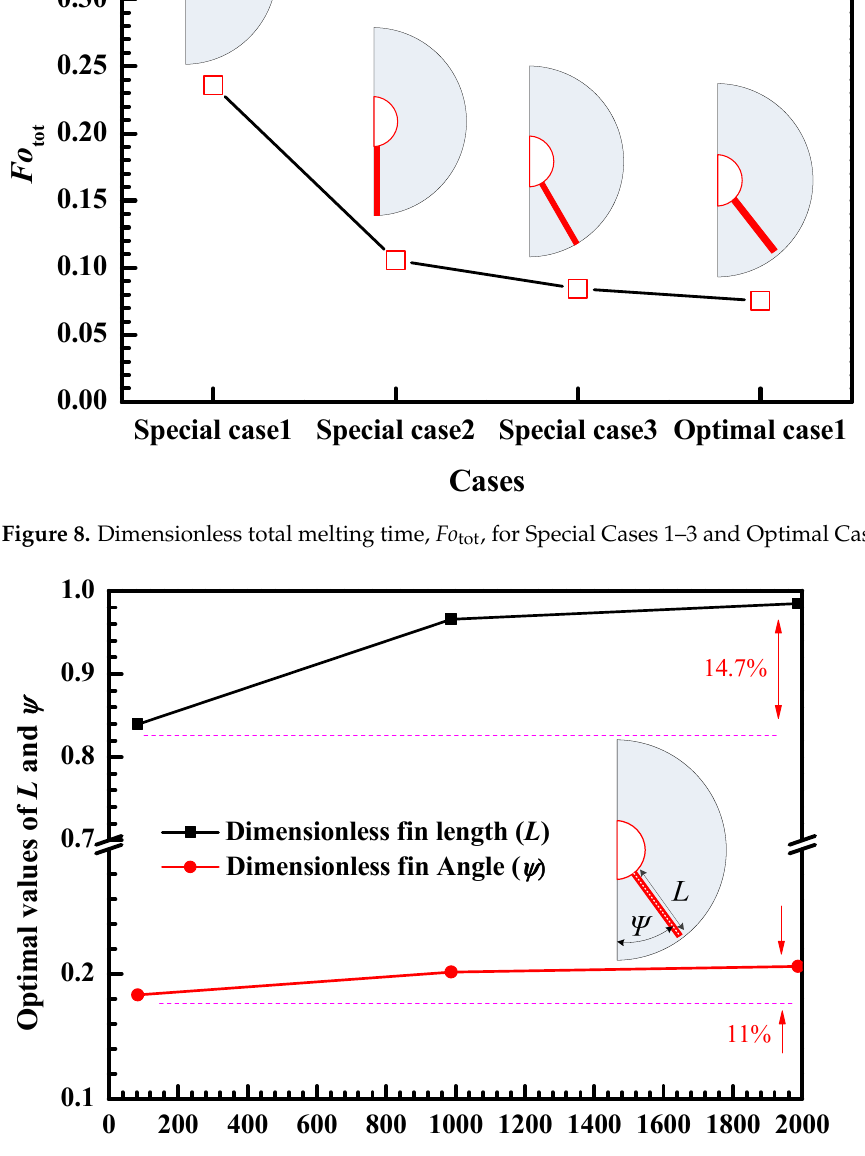
Figure 10. Contour maps of liquid fraction and dimensionless temperature for Optimal Cases 2, 4 and 5 and Special Case 4. To further prove different fin designs for different λ fin / λ PCM values, a special case called Special Case 4 was designed. Special Case 4 uses the same fin as Optimal Case 2, but the λ fin / λ PCM is set to 83.6. The distribution of liquid fraction and dimensionless tem- perature for Special Case 4 is also shown in Figure 10. It can be seen that, for the same λ fin / λ PCM , the melting rate of the PCM under the fin in Special Case 4 is slower than that in